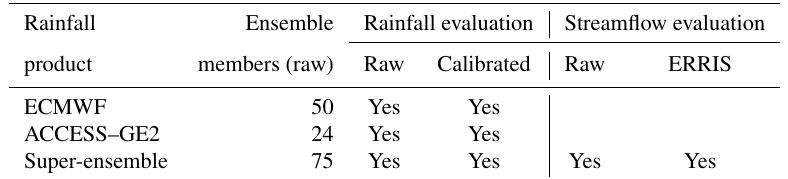
Table 2. Forecast evaluation experiments.